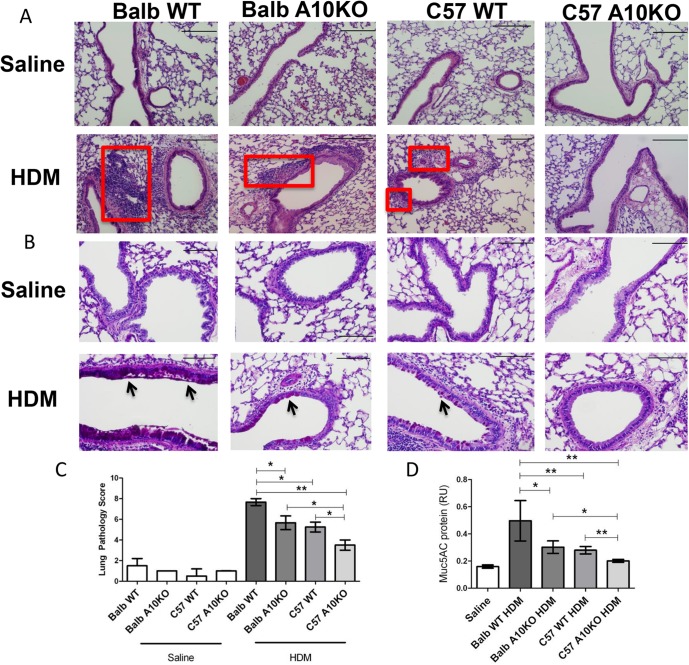
B-ADAM10 deletion reduces cellular infiltration, goblet cell metaplasia, and mucus production in a strain dependent manner.(A) H&E stain for lung tissue demonstrates peribronchiolar and perivascular inflammatory cellular infiltration (red box); 10x magnification, scale bar 200 μm. (B) Goblet cell metaplasia determined by PAS stain; note dark pink mucin producing cells (black arrow) and alveolar epithelium thickness; 20x magnification, scale bar 100 μm. (C) Lung pathology score representing quantitation of peribronchiolar and perivascular inflammatory cellular infiltration on H&E stained lung sections; 2 sections per mouse and at least 4 mice per group were assessed. (D) MUC5AC protein. n = 7–9 per group, 3 independent experiments. All mice immunized with saline demonstrated comparable results. For simplicity, saline represents Balb WT mice given saline. *p<0.05, **p<0.005.